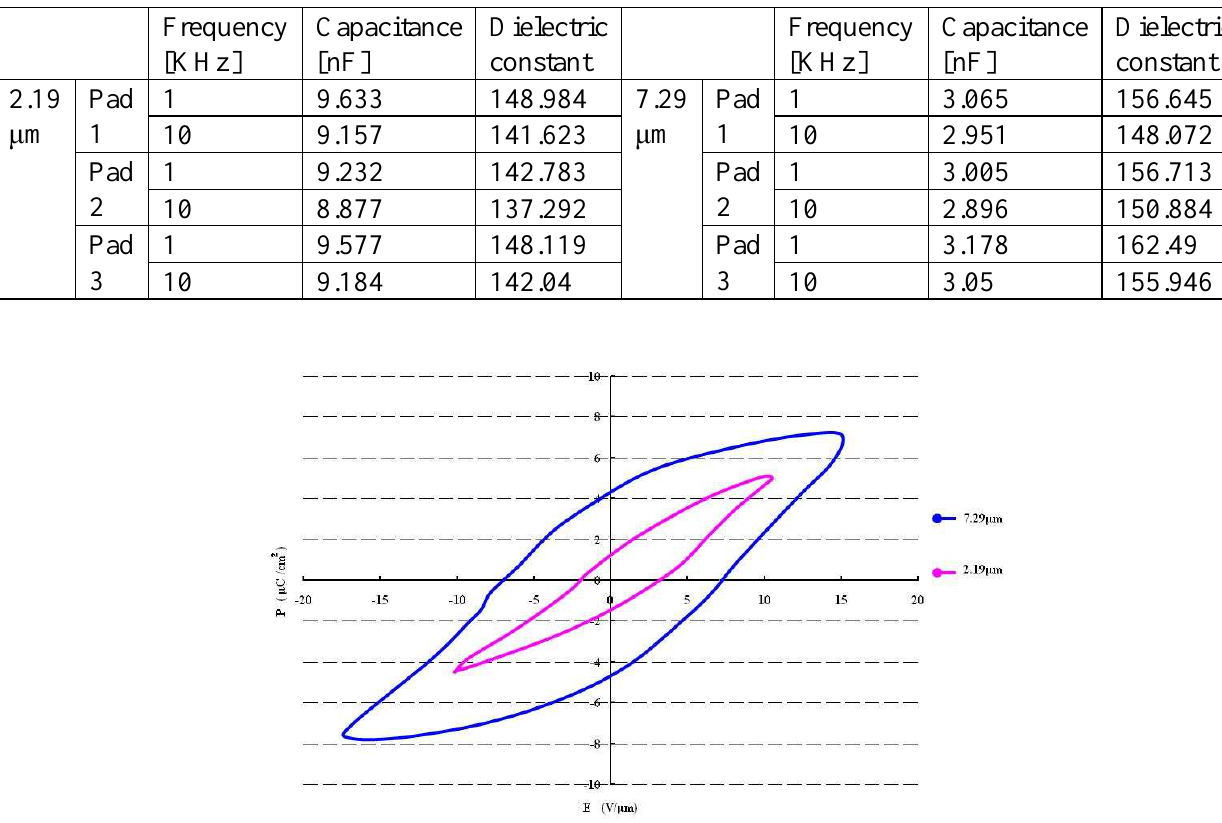
Table 1 . Capacitance and dielectric constant of PZT films with an area of 4 mm x 4 mm.